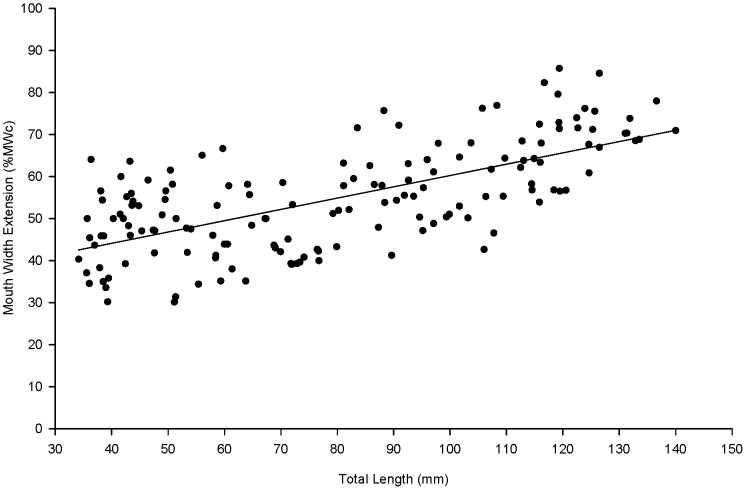
Relationship between mouth width extension (MWE, %MWc) and total length (TL, mm) of juvenile barramundi.MWE and TL are positive correlated (r = 0.660, n = 154, P<0.0001). The solid line represents the average MWE varying from 34 to 140 mm TL and is expressed as MWE = 0.269(0.024)TL + 33.328(2.083) (r
2 = 0.446, df = 152, F = 121, P<0.0001).